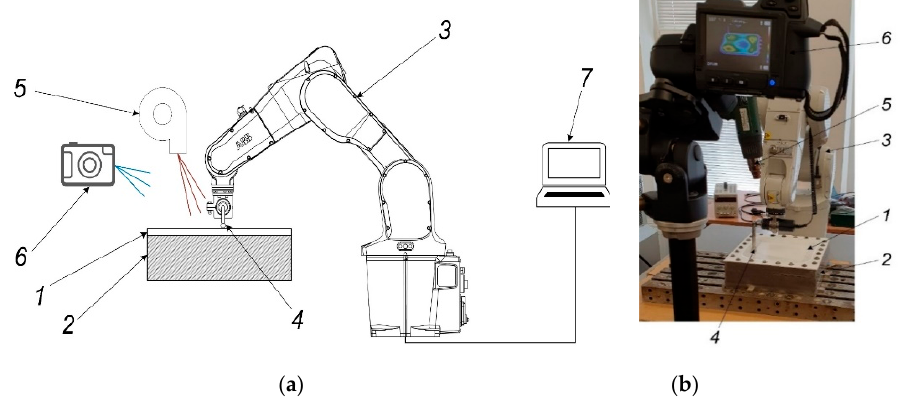
Figure 16. Experimental investigation of forming four geometric shapes from polymer sheet: ( a ) scheme; ( b ) stand view. Here: 1—PVC ESA-D polymer sheet, 2—holding frame, 3—robot ABB IRB1200 (ABB Robotics & Discrete Automation, Västerås, Sweden), 4—forming tool, 5—heat gun Toolland PHG2 (Tooland Inc., San Carlos, CA, USA), 6—thermal imaging camera FLIR T450sc (FLIR Systems Inc., Wilsonville, OR, USA), 7—PC.